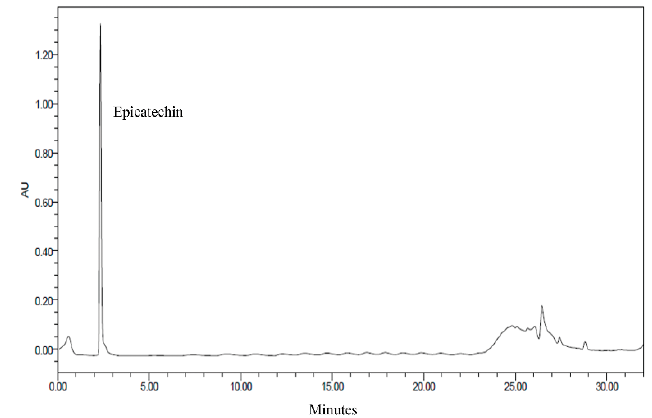
Figure 1. High-performance liquid chromatography (HPLC) chromatogram of cocoa nibs extract.